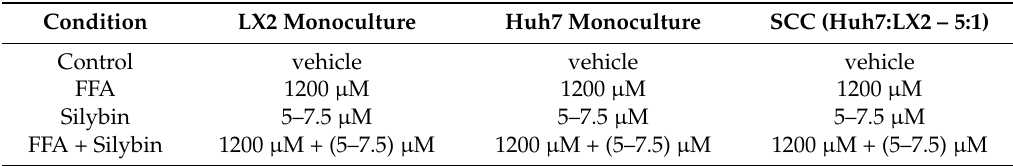
Table 1. Summary of the experimental conditions.